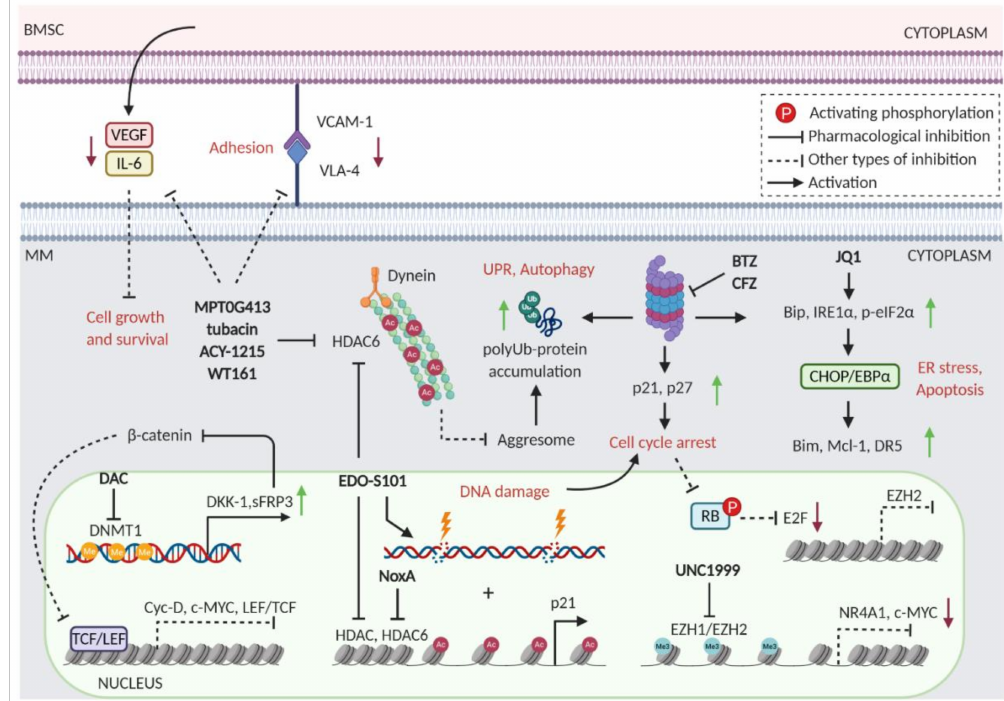
Figure 5. The molecular mechanisms underlying the effects of proteasome inhibitors (PIs) combination with epigenetic inhibitors. A plethora of anti-myeloma effects are observed by targeting epigenetic reprogrammers in combination with proteasome inhibition. HDAC6 specific inhibitors (MPT0G413, Tubacin, ACY-1215, WT161) lead to increased α -tubulin acetylation and to the inhibition of aggresomal pathways, thus activating unfolded protein response (UPR) and autophagy pathways. This mechanism is emphasized by proteasome inhibition. MPT0G413 can also affect MM cell growth, survival and adhesion to bone marrow stromal cells(BMSCs), through the inhibition of adhesion molecules and cytokines expression. The fusion molecule EDO-S101 acts as HDAC inhibitor as well as alkylating agent. EDO-S101 promotes polyUb-proteins accumulation, p21 expression, and induces DNA damage. Multiple pathways are responsible for the synergy between EDO-S101 and proteasome inhibitors, such as UPR hyper-activation, induction of autophagy, inhibition of cell cycle via upregulation of p21, and reduction of c-MYC expression. The BET inhibitor JQ1 in combination with carfilzomib enhances CHOP/EBP α -dependent Bim and Mcl-1 transcription, thus triggering ER stress and apoptosis. The DNA hypomethylating agent decitabine (DAC) demonstrated synergistic anti-MM effects in combinations with bortezomib. It is speculated that DAC inhibits β -catenin activity by promoting the expression of Wnt antagonists (DKK-1 and sFRP3). The EZH1/EZH2 inhibitor UNC1999 enhances the cytotoxicity of PI through a cooperative repression of MYC